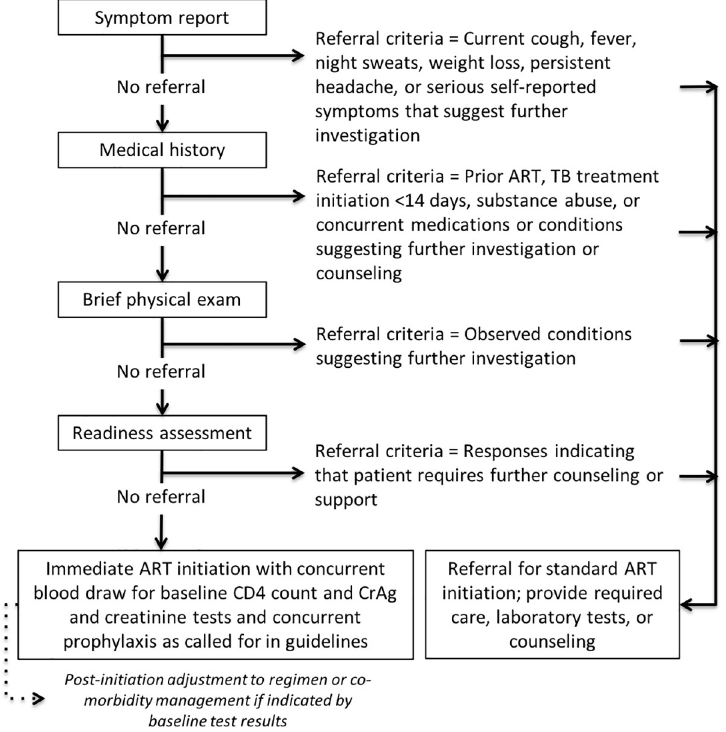
Fig 2. SLATE algorithm to support same-day HIV treatment initiation. ART, antiretroviral therapy; CrAg, cryptococcal antigen; SLATE, Simplified Algorithm for Treatment Eligibility; TB, tuberculosis.